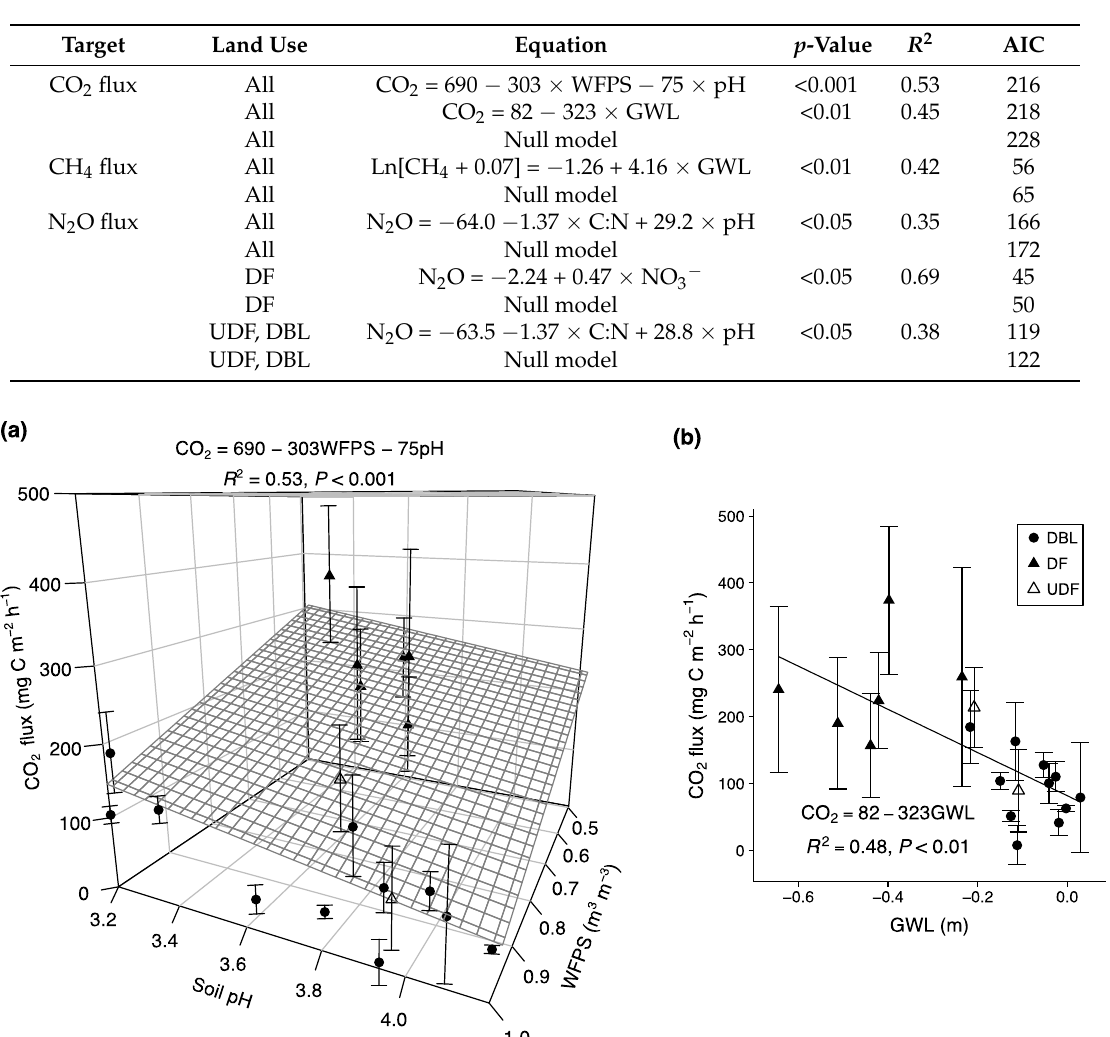
Table 3. Multiple regression analysis for GHG (greenhouse gas) fluxes. R 2 represents the determination of coefficients, and AIC represents Akaike information criterion (Akaike 1987). Higher R 2 and lower AIC show better model.